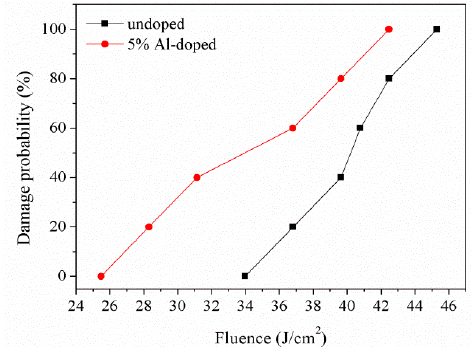
Figure 5. Bulk LIDT of undoped and Al-doped CLBO crystals.